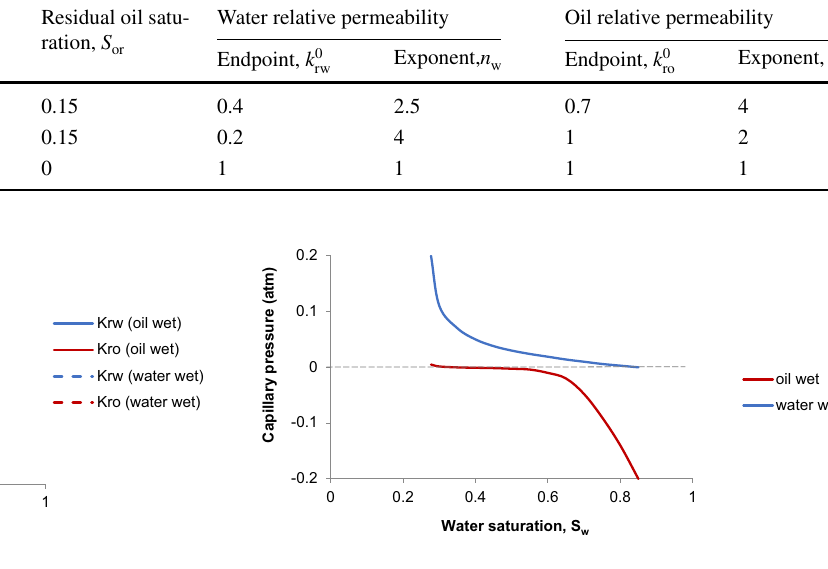
Fig. 3 Capillary pressure of matrix at oil-wet condition and water-wet